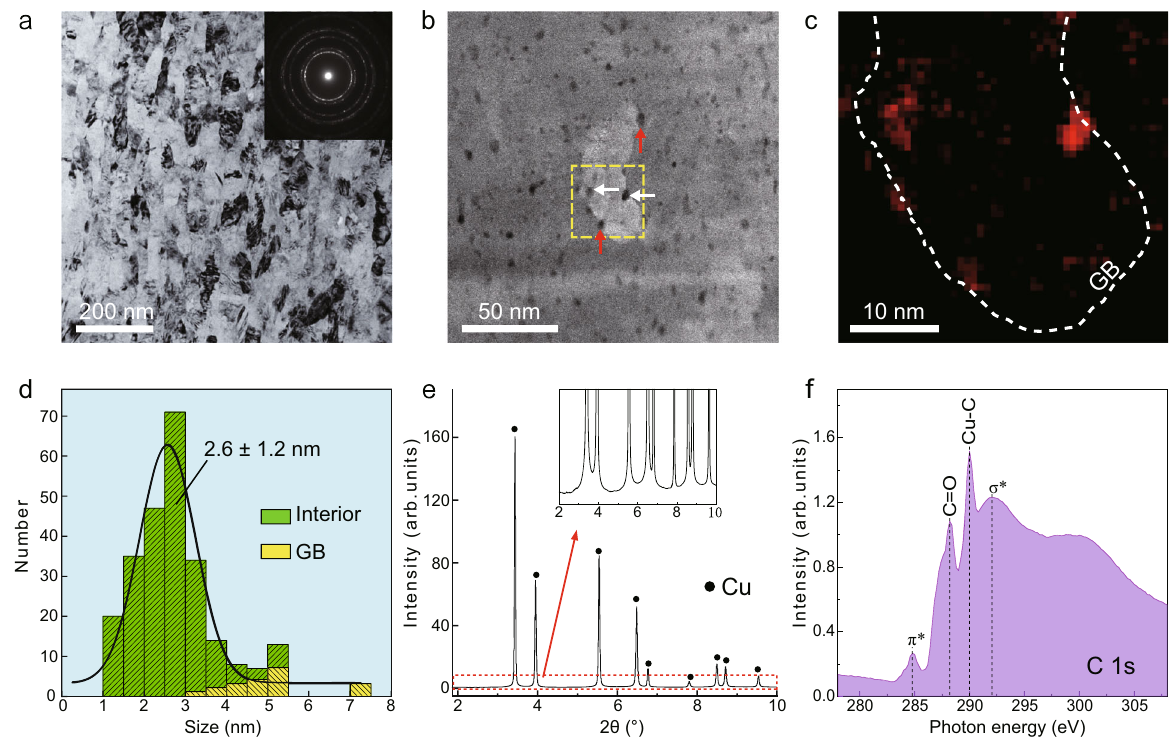
Fig. 1 | Microstructure of nc-Cu composites dispersed with unc particles. a Abright- fi eld(BF)TEMimageshowingnanocrystallinegrainsinanas-synthesized composite, as con fi rmed by nearly uniform diffraction rings in the inset. An aperture size of 1 μ m was used. b An HAADF-STEM image of nc-Cu with a C con- centrationof0.8vol.%,whereahighdensityofuncparticlesisobserved.Someunc particleswithingrainsandalonggrainboundaries(GBs)areindicatedbywhiteand redarrows,respectively.BF-andHAADF-STEMimagesareusedtogethertoidentify GBs. c EELSCimagingmapfortheboxedareain b wheretheGBisdelineatedbythe